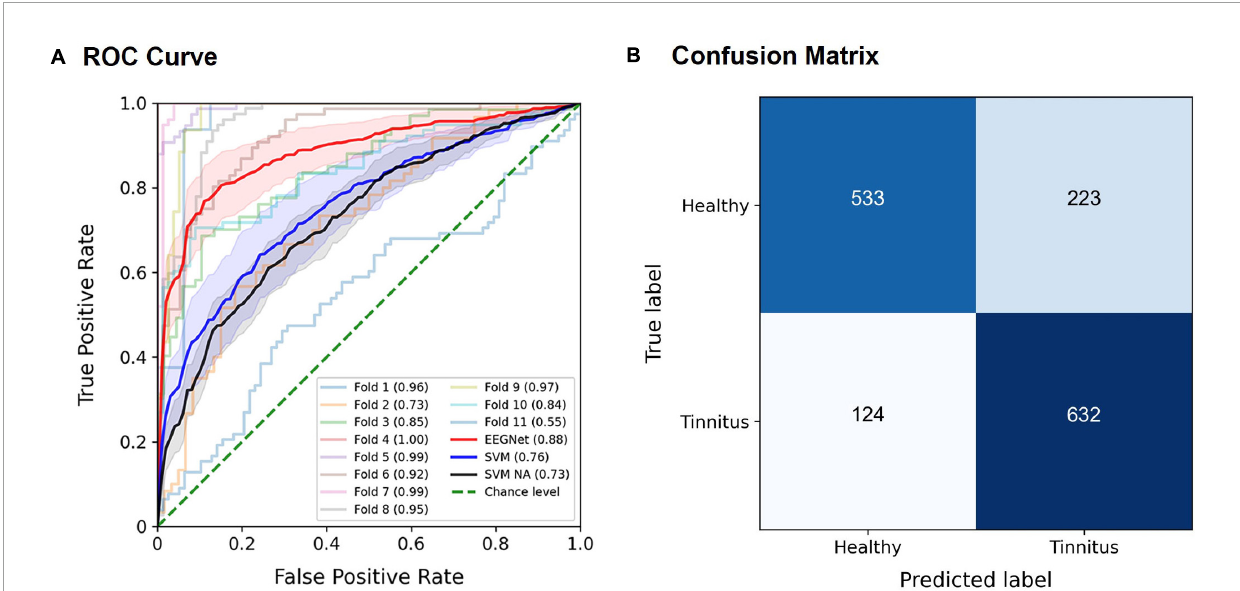
FIGURE4 Classification performance of the EEGNet model for the target stimuli in the active oddball task using EEG alpha activity. (A) The area under the curve (AUC) scores of each fold in the receiver operating characteristic (ROC) curves were obtained through 11-fold leave-one-pair-out cross-validation using EEG alpha activity in the target stimuli during the active oddball task. Each curve represents the ROC curve for each fold in the cross-validation, with the corresponding AUC scores noted within the legend. The red solid line represents the EEGNet-based averaged AUC across 11 folds, and the blue solid line represents the SVM-based averaged AUC across 11 folds. The black solid line represents the SVM-based averaged AUC based on the removal of the alpha band from the input signals (noted as “SVM NA” in the legend). The green dotted line indicates the chance level. Error bands indicate standard errors of the mean (EEGNet in red, and SVM in blue, and SVM NA in dark gray). (B) Confusion matrix of the EEGNet model classification